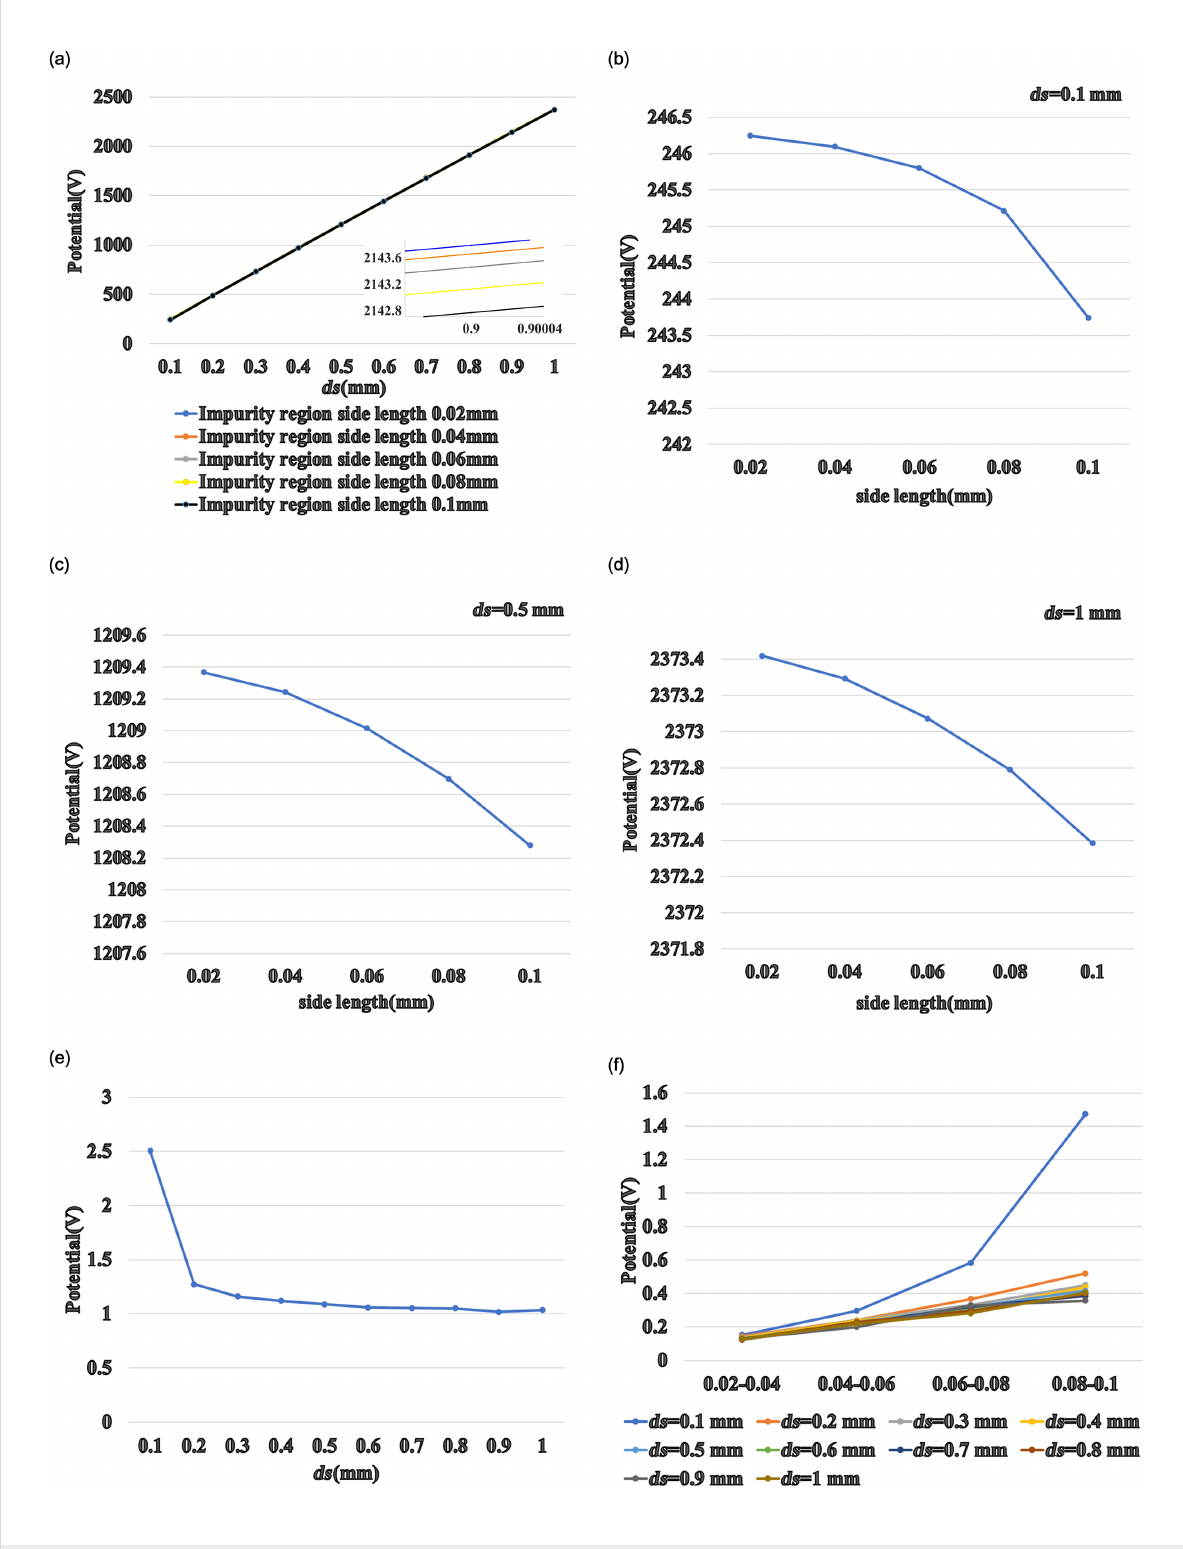
Figure 7: (a) The potential of the TENG varies with distance ds for different sizes of the gas injection area. The TENG potential as a function of the gas injection area with (b) ds = 0.1 mm, (c) ds = 0.5 mm, and (d) ds = 1 mm. (e) TENG potential difference as a function of ds . (f) TENG potential difference of rectangular cross sections with different side